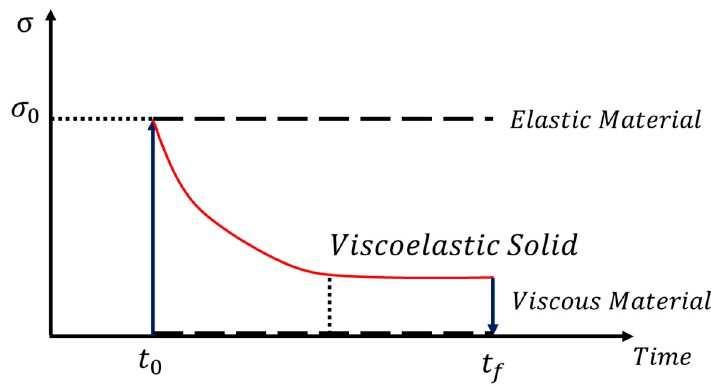
Figure 14. Stress relaxation behavior of the viscoelastic material.